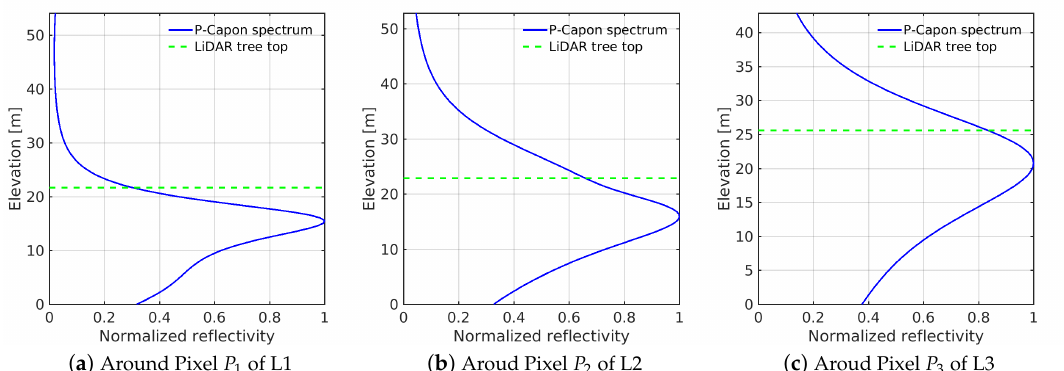
Figure 7. Normalized vertical reflectivity profiles estimated by P-Capon technique at the locations indicated in Figure 6. Elevation here is measured with respect to the LiDAR ground